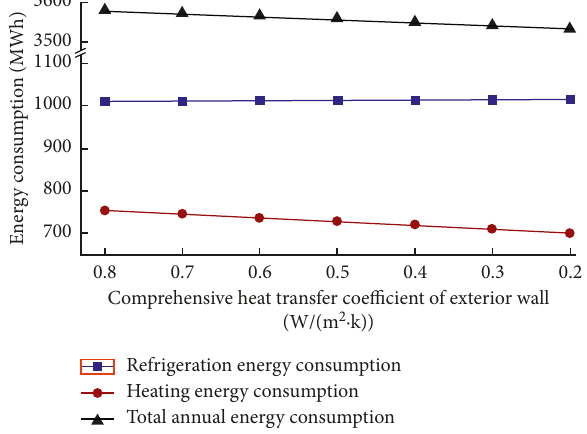
Figure 8: Variation in the building energy consumption when the comprehensive heat transfer coefficient of the external wall